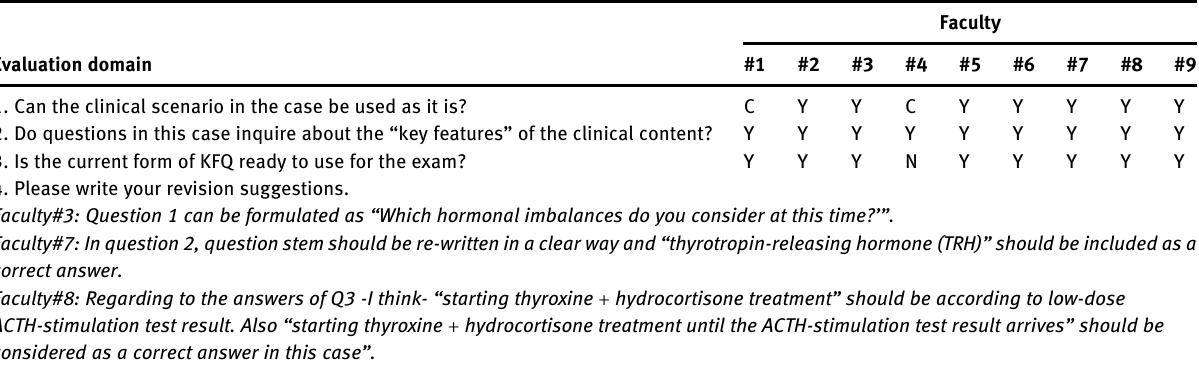
Table  : Faculty peer feedback on KFQs-Case- 